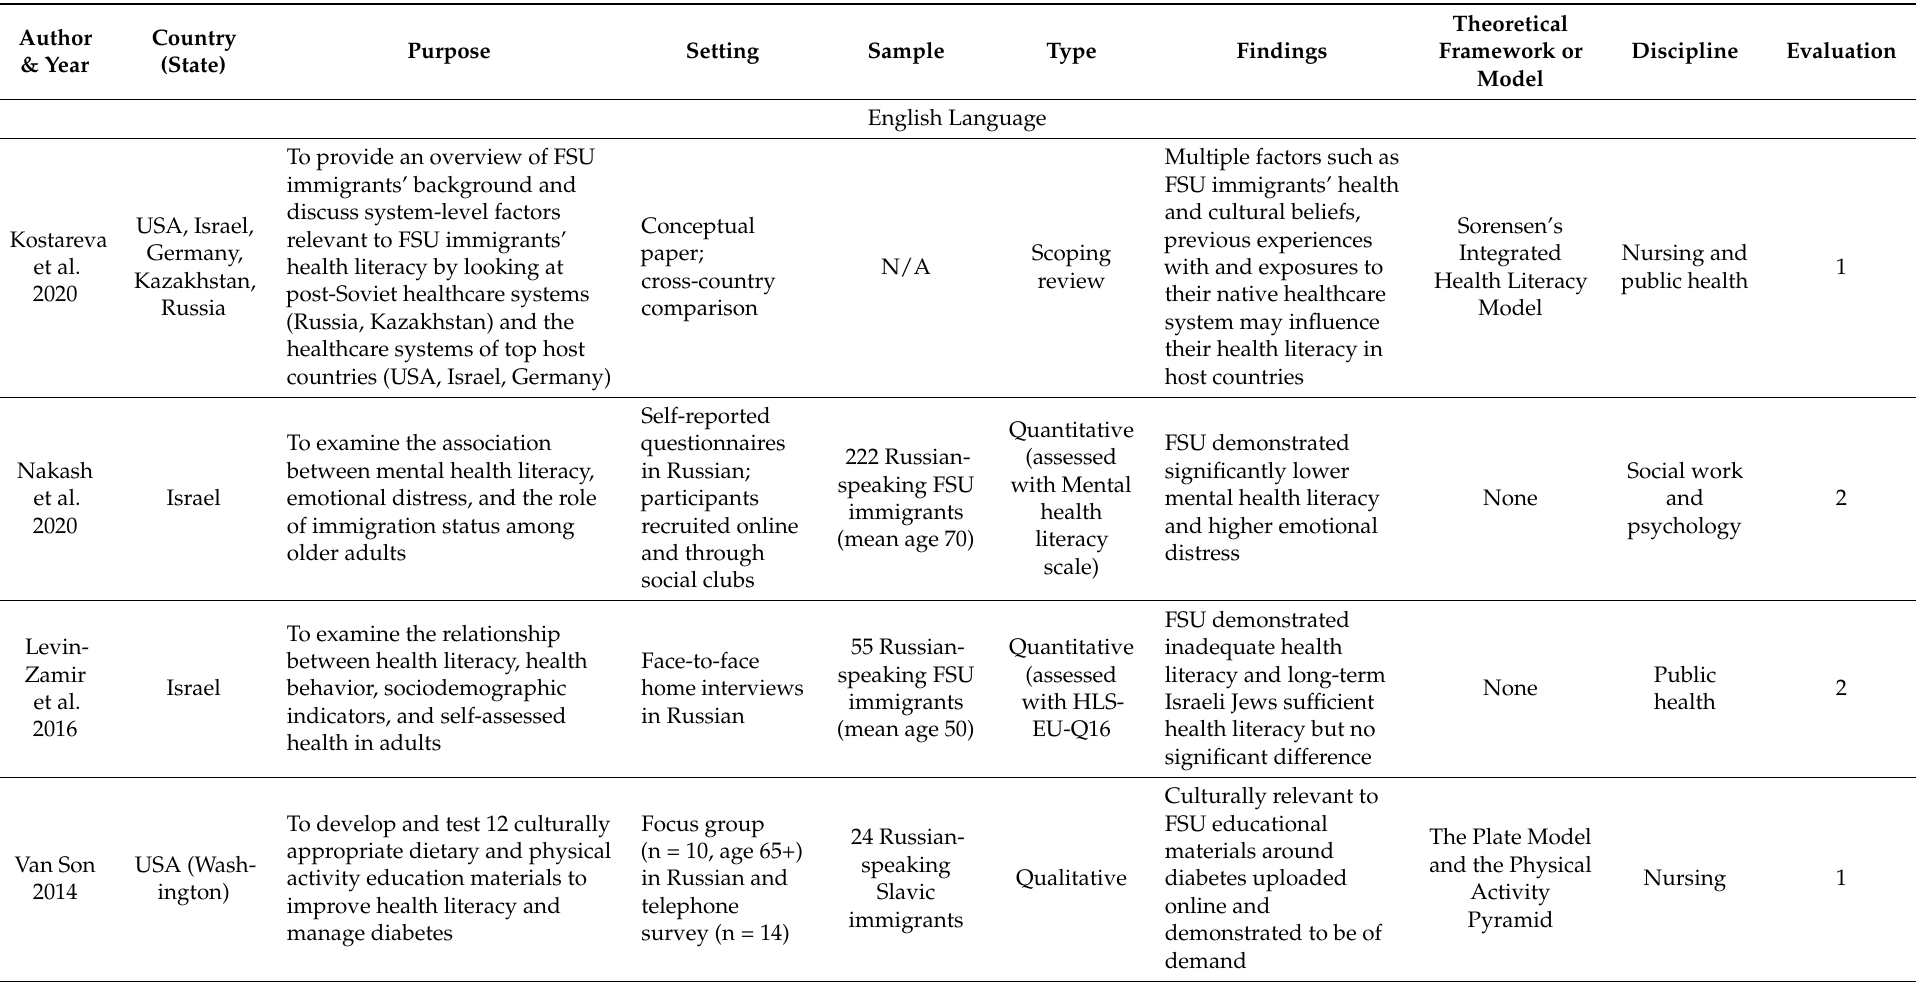
Table 3. Summary of